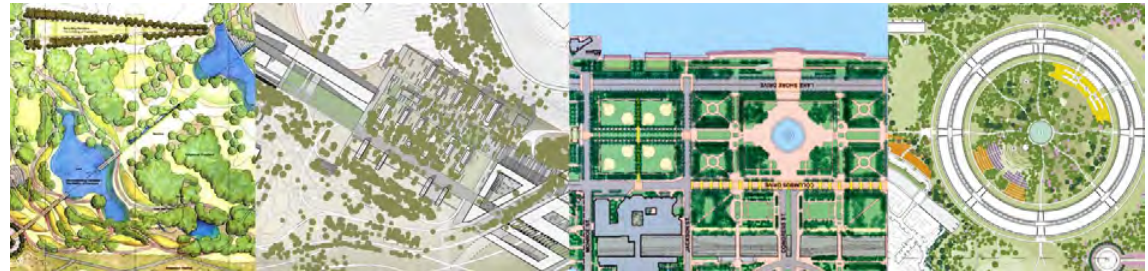
Figure 1. Park landscaping systems (Sources: Bureau, Partners, Site-Design, n.d.).